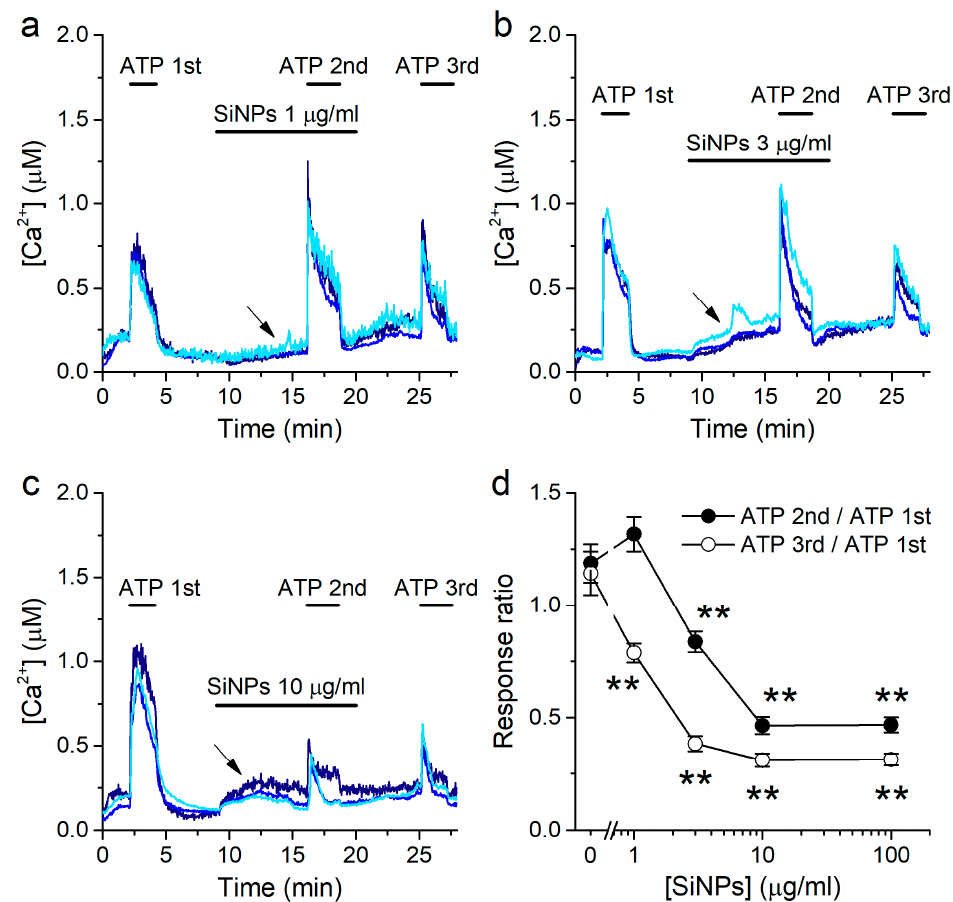
Figure 3. SiNPs induce a concentration-dependent inhibition of the response to ATP. ( a – c ) Examples of intracellular [Ca 2+ ] traces showing the effects of SiNPs when applied at 1 µ g/mL ( a ), 3 µ g/mL ( b ) or 10 µ g/mL ( c ), before and during the 2nd application of 10 µ M ATP. The arrows point to the increase in intracellular [Ca 2+ ] induced by the application of the SiNPs. ( d ) Ratio between the amplitudes of the responses to the 2nd and 3rd applications of ATP and the amplitude of the response to the 1st application of ATP, as a function of the concentration of SiNPs. The data are represented as mean ± s.e.m. ( n = 135, 135, 52 and 92 for SiNPs at 1, 3, 10 and 100 µ g/mL, respectively. The asterisks (**) denote statistically significant difference with respect to the corresponding control data [SiNPs] = 0 µ g/mL ( p < 0.01; Kolmogorov-Smirnov